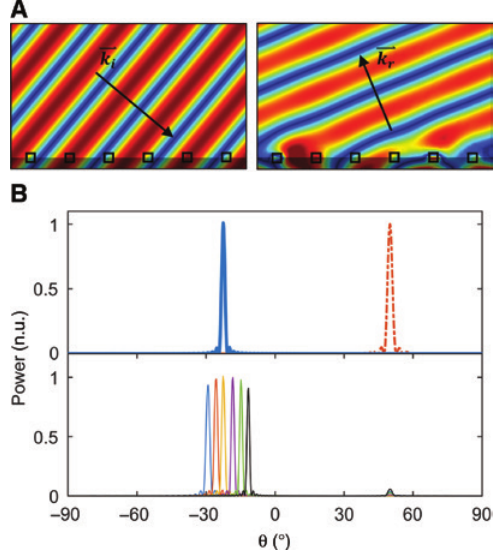
Figure 19: Experimental demonstration of the anomalous reflection BHM. (A) A close-up of the fabricated BHM. Obtained from [71]. (B) A photograph of the experimental apparatus, showing the transmit (Tx) and receive (Rx) antennas, as well as the metasurface. Obtained from [71]. (C) The measured bistatic RCS (blue, solid), compared alongside that for a metallic plate of the same size and shape (red, dashdot). Obtained from